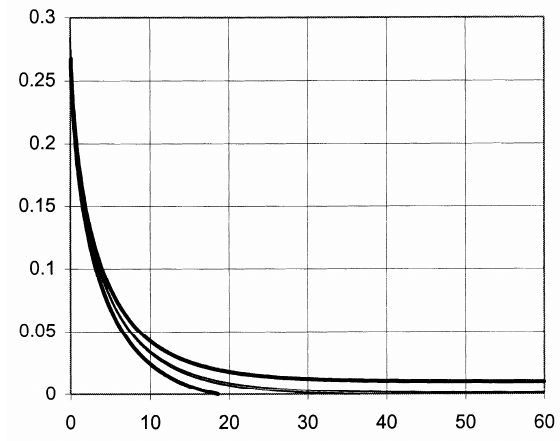
Figure 1 – Inverse Gaussian, with mean 1, variance 5 and (cid:84) =2.5, using (cid:39) =0.05 and (cid:39) =0.005.